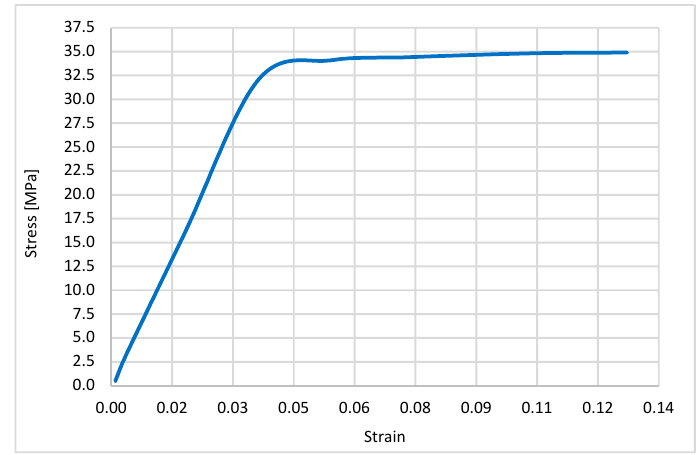
Figure 11. Stress/strain curve of acrylonitrile butadiene styrene (ABS) Plus.